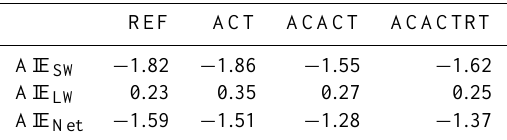
Table 5. Global mean aerosol indirect radiative effect in each model configuration given in terms of the shortwave (AIE SW ), longwave (AIE LW ) and net (AIE Net ) radiative forcing in Wm − 2 .